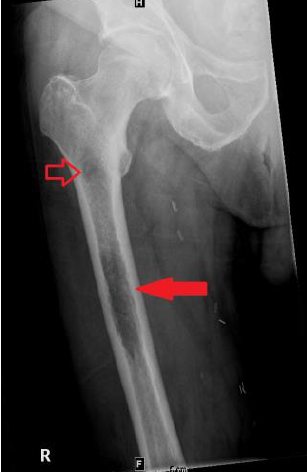
Figure 2. Frontal view radiograph of the right femur demonstrating a 10 cm in length lytic lesion of the proximal half of the femoral diaphysis (solid arrow), with a smaller lesion more proximally (open